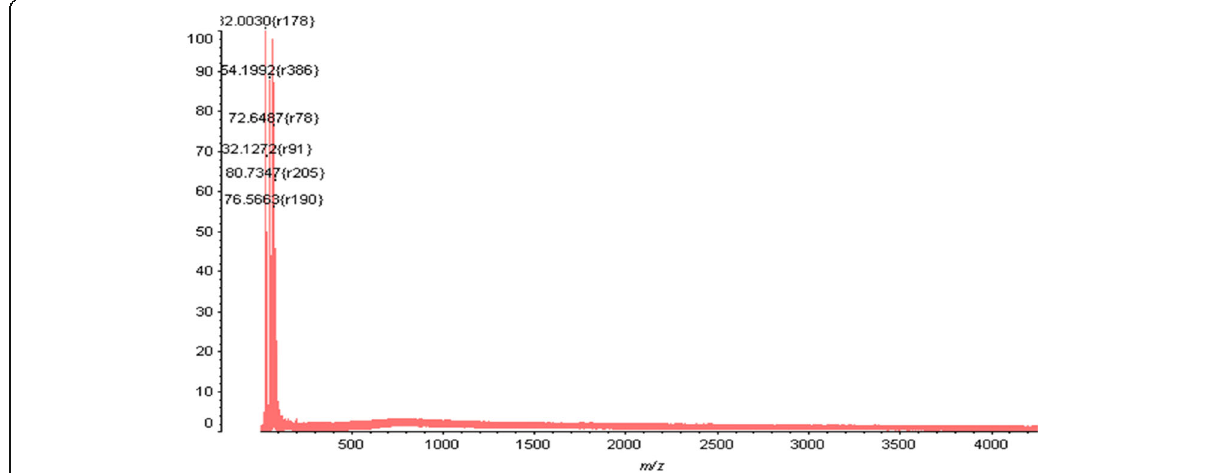
Fig. 5 The intense peaks of MALDI-ToF mass spectrum of partially acid-digested EPS